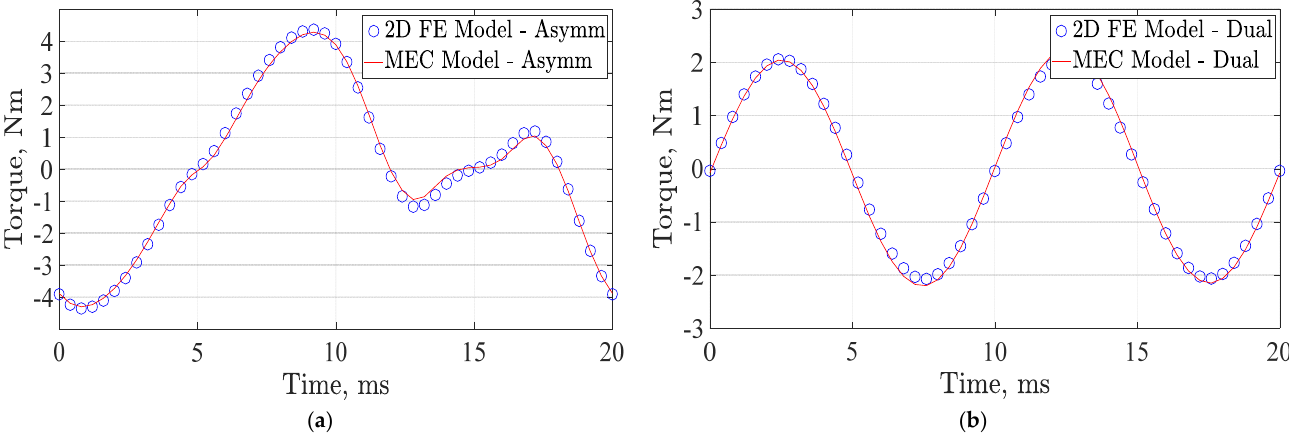
Figure 15. Torque profiles under charging mode. ( a ) Asymmetrical winding layout and ( b ) dual three ‐ phase winding layout.